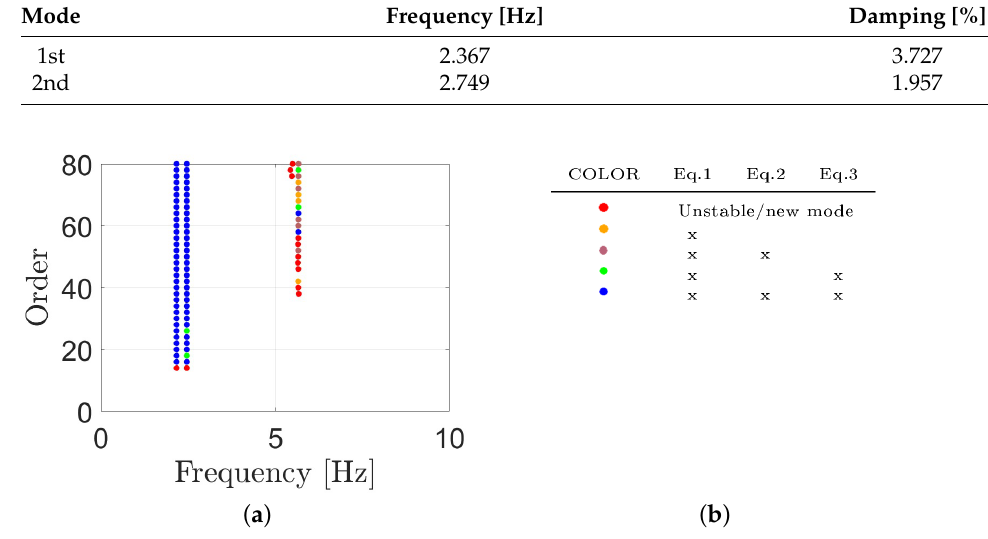
Figure 21. ( a ) Stabilization diagram obtained from SSI-cov analysis; ( b ) Legend of the colors. The modes are translational in two orthogonal directions, see Figure